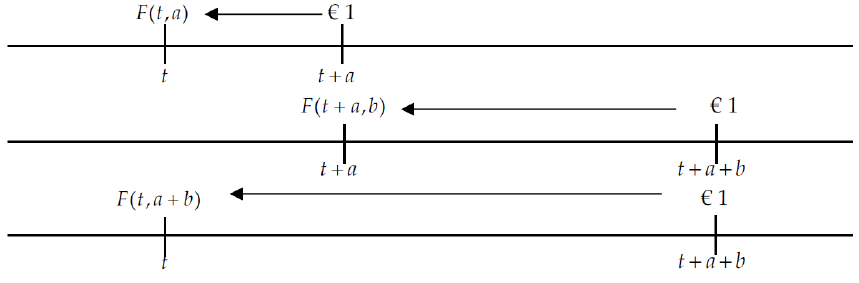
Figure 1. Additivity. Source: Own elaboration.